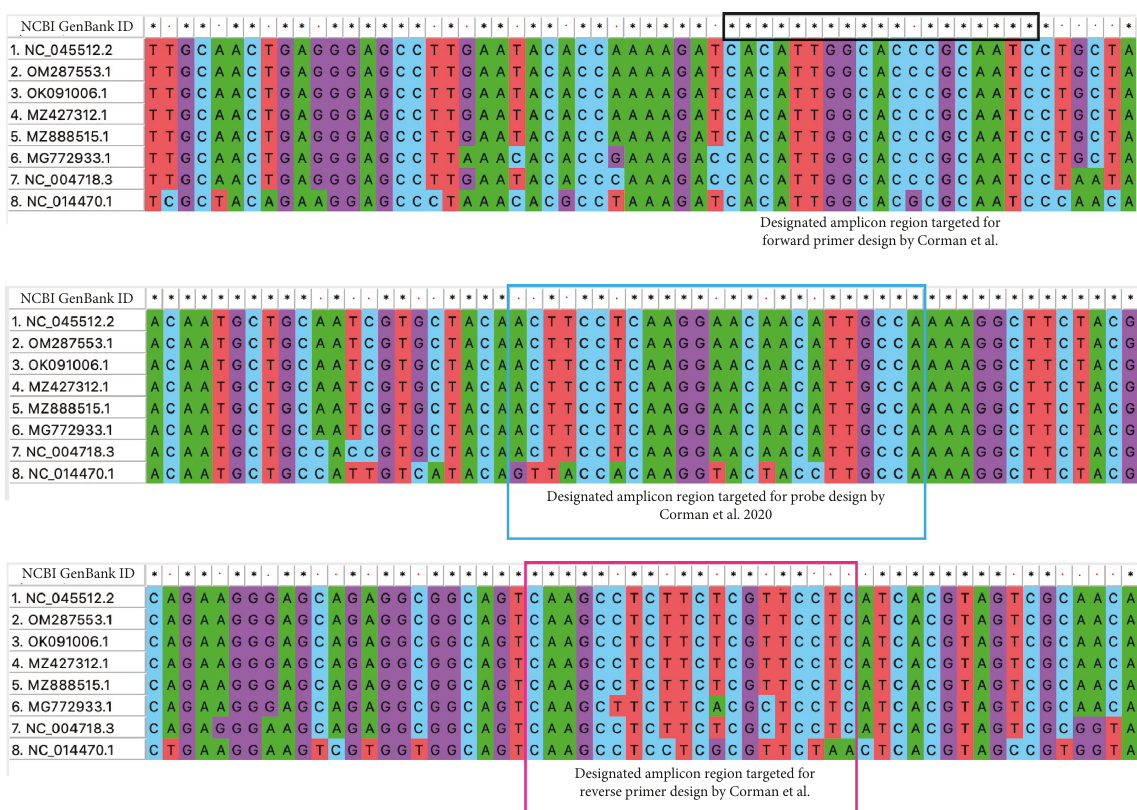
Figure 2: N gene designated fragment—MSA (MUSCLE) by MEGA11 version 0.1. The region of primers and probe is designed by [1]. Star ) signs denote perfect nucleotide position match, and red dots (.) denote mismatch. The black rectangle shape denotes the amplicon region ( for forward primer design, the blue rectangle shape denotes the amplicon region for probe design, and the pink rectangle shape denotes ∗ amplicon position for reverse primer position. Analyzed NCBI GenBank accession IDs for MSA for the entire E gene represent as follows: analyzed NCBI GenBank accession IDs for multiple sequence alignment for the N gene fragment represent as follows: 1. NC_045512.2: N gene designated fragment (nucleotide sequence: 28671–28850, 180bp), SARS-CoV-2 isolate Wuhan-Hu-1, SARS-CoV-2 ref. Genome;